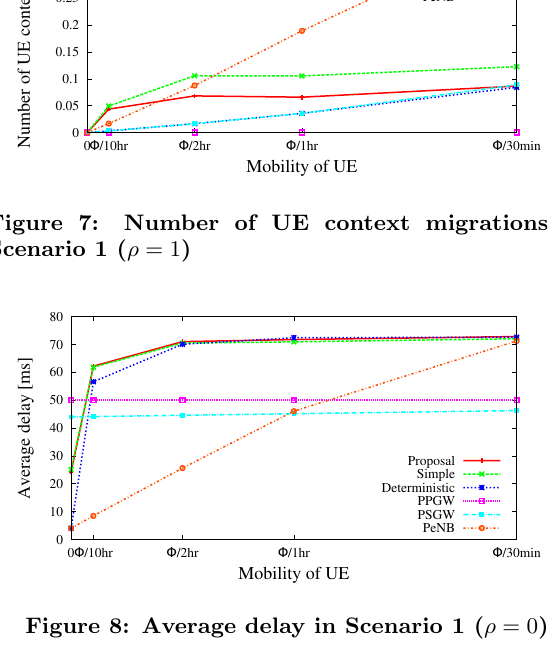
Figure 8: Average delay in Scenario 1 ( ρ = 0 )